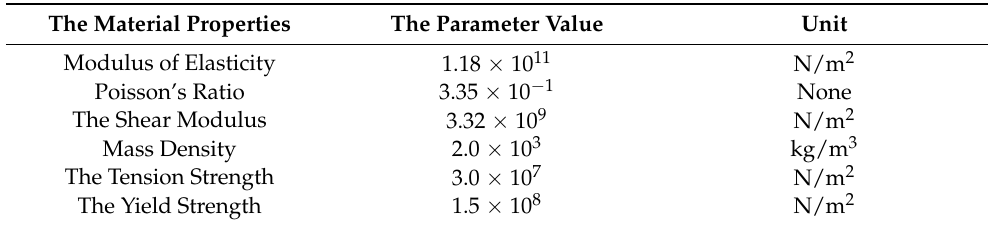
Table 2. Carbon fiber board material